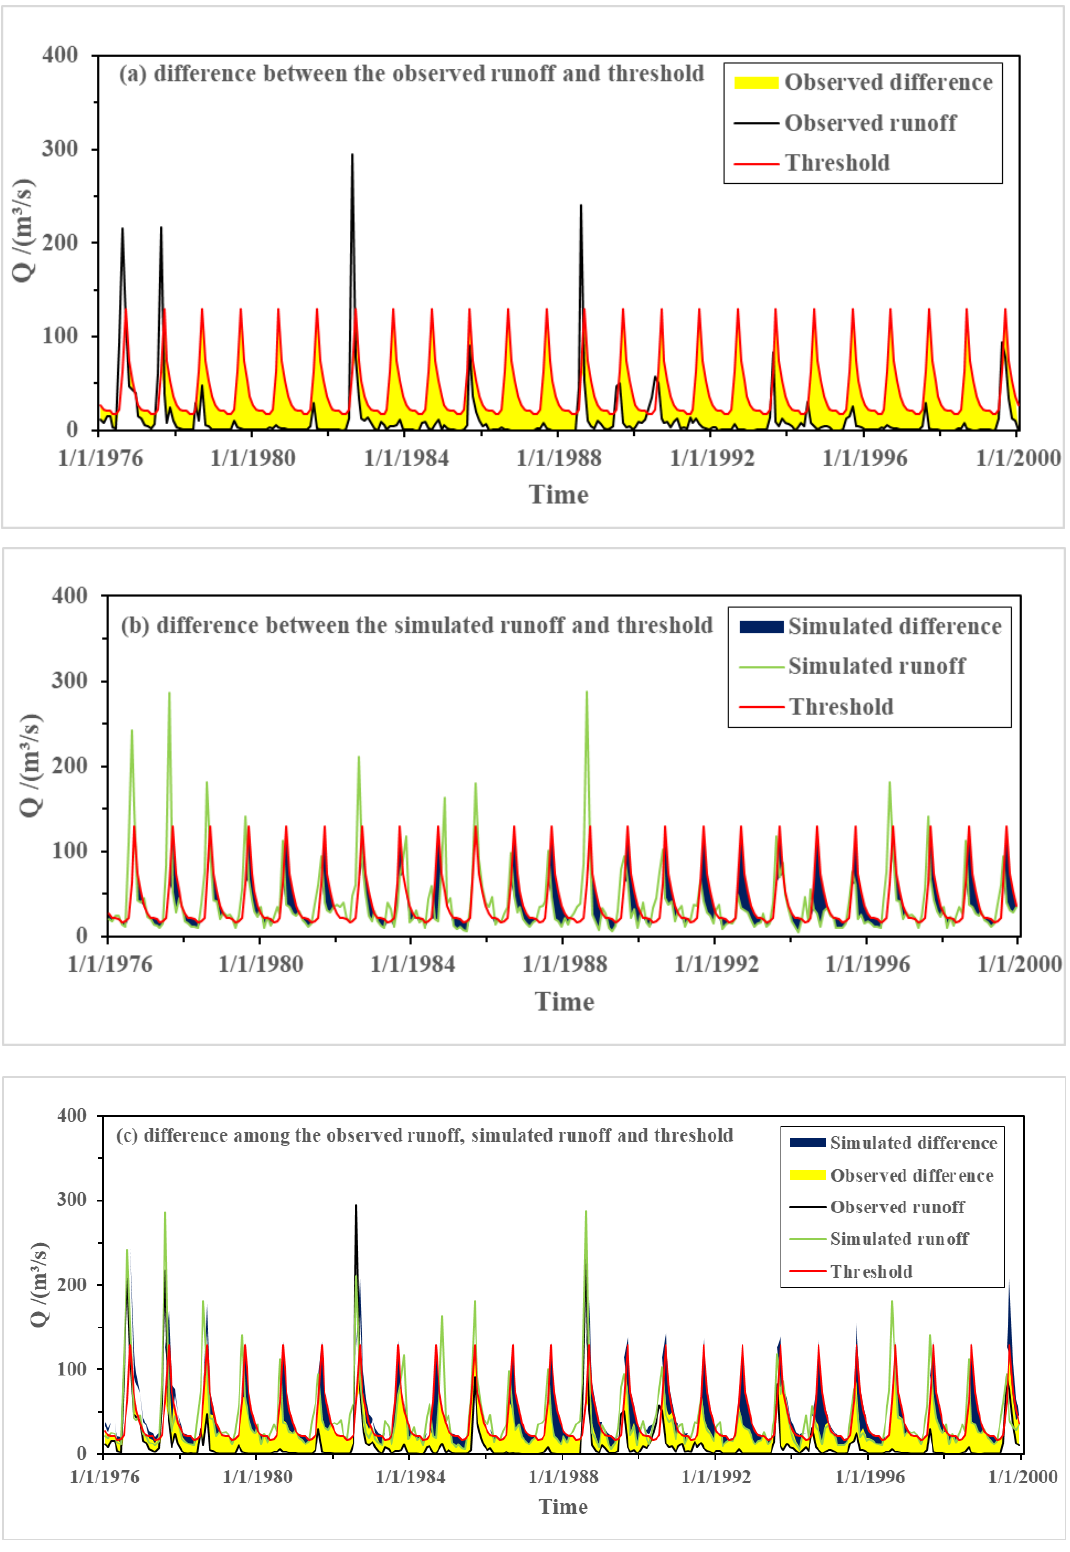
Figure 8. Di ff erences among the observed runo ff , simulated runo ff and threshold during the human Figure 8. Differences among the observed runoff, simulated runoff and threshold during the human disturbance period from 1976 to disturbance period from 1976 to 1995.